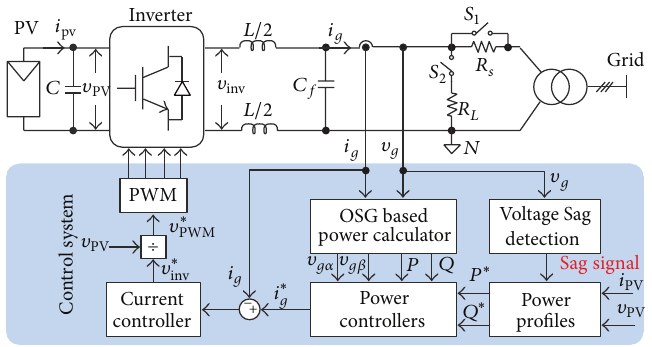
Figure 3: Overall structure of a single-phase grid-connected PV system, OSG: Orthogonal Signal Generator.